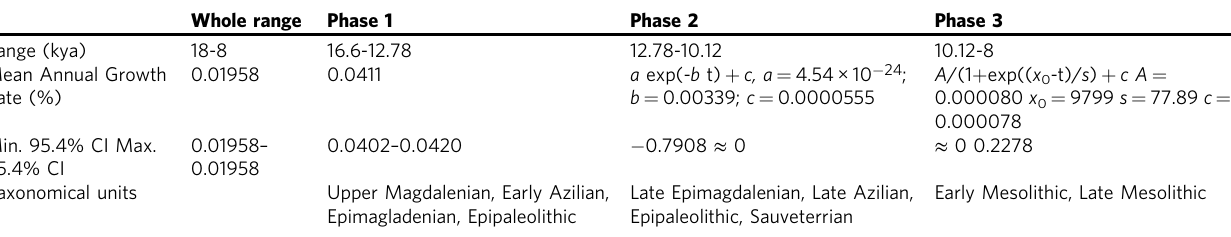
Table 1 Growth rates derived from the model E for each demographic phase in Iberia (18-8